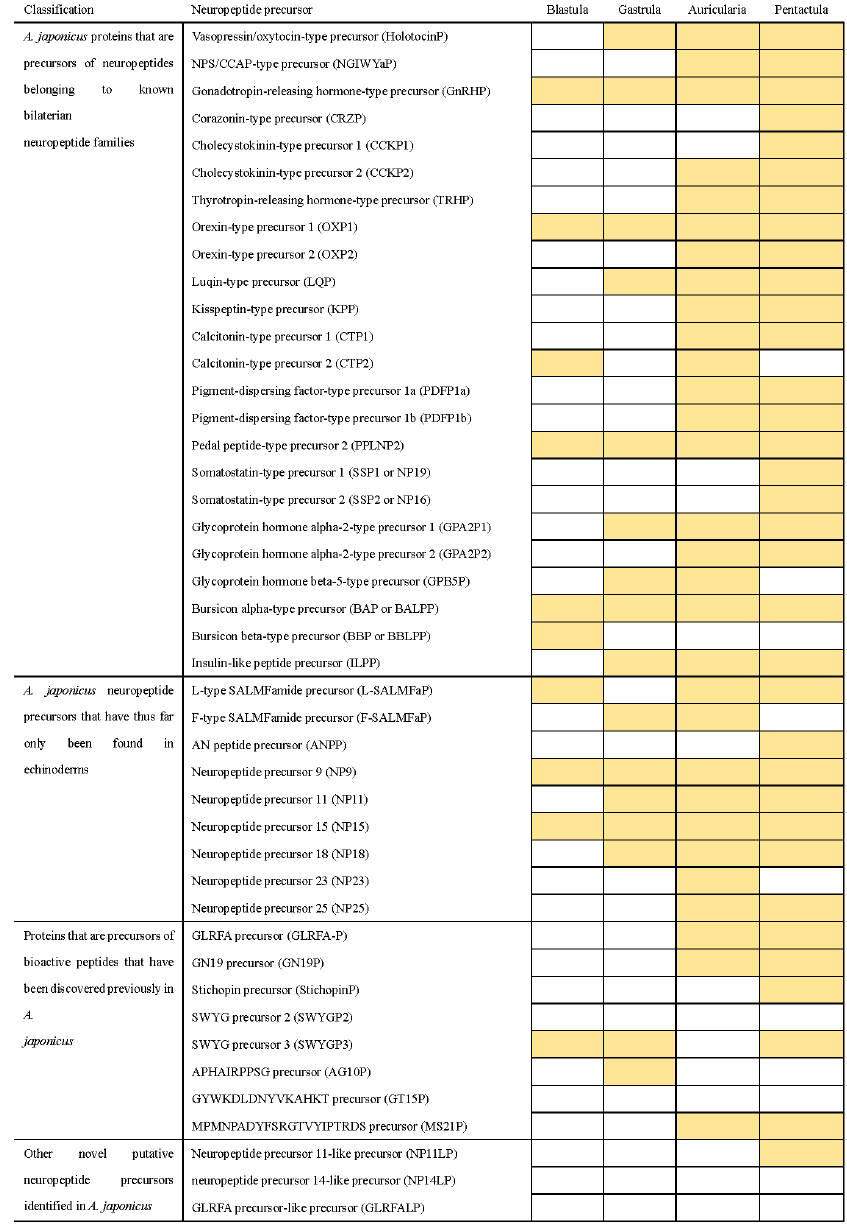
Figure 4. Blast-based identification of neuropeptide precursors in A. japonicus embryos and larvae. The shading indicates that the transcripts of NP were identified.